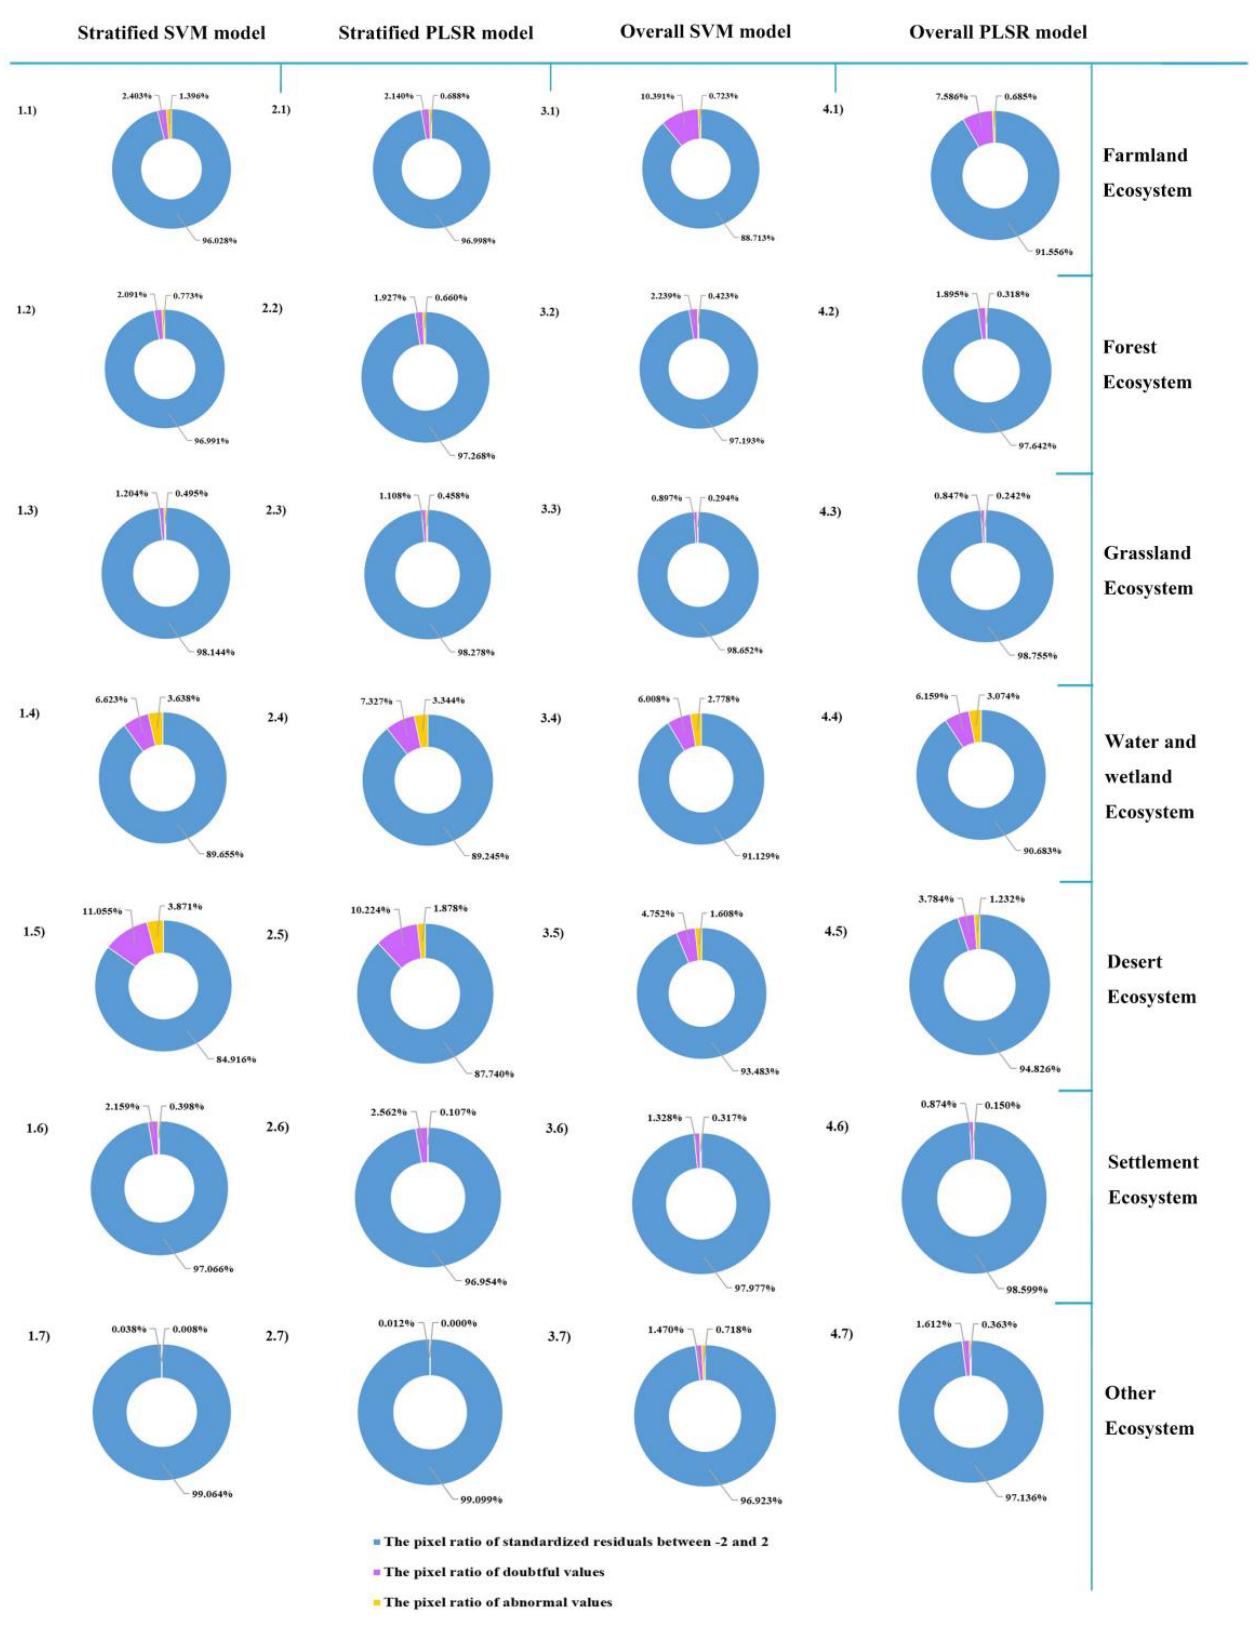
Figure 12. The ratio of pixel numbers of the standardized residuals of the seven ecosystem types analyzed here in each interval to the total pixel numbers in each ecosystem type.